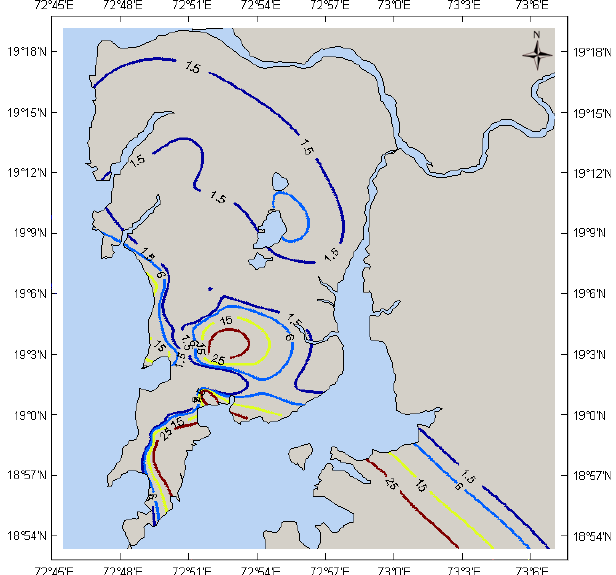
Fig. 8. Contour map of liquefaction potential index (LPI) for earth- quake of magnitude M w = 7.0 of 2475-yr return